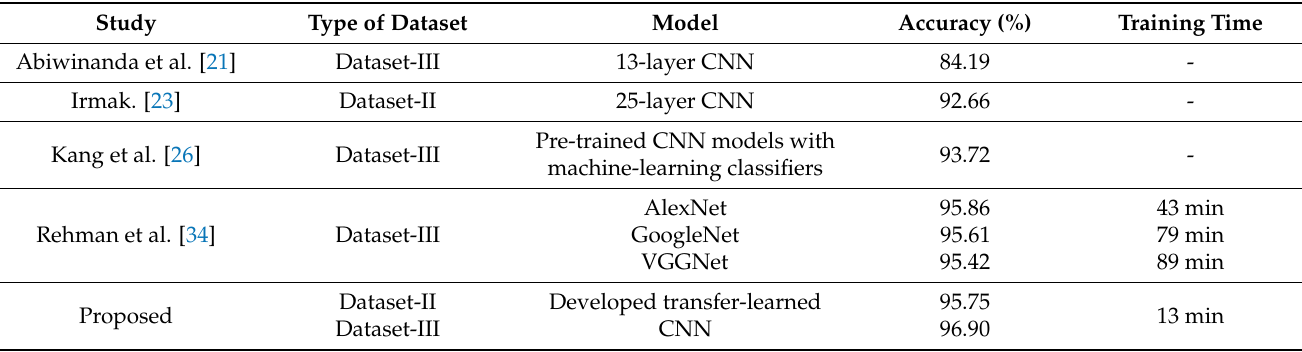
Figure 8. Receiver operation characteristic (ROC) curves for dataset-III; ( a ) glioma; ( b ) meningioma; ( c ) pituitary. Table 6. Performance comparison of the proposed model with literature.